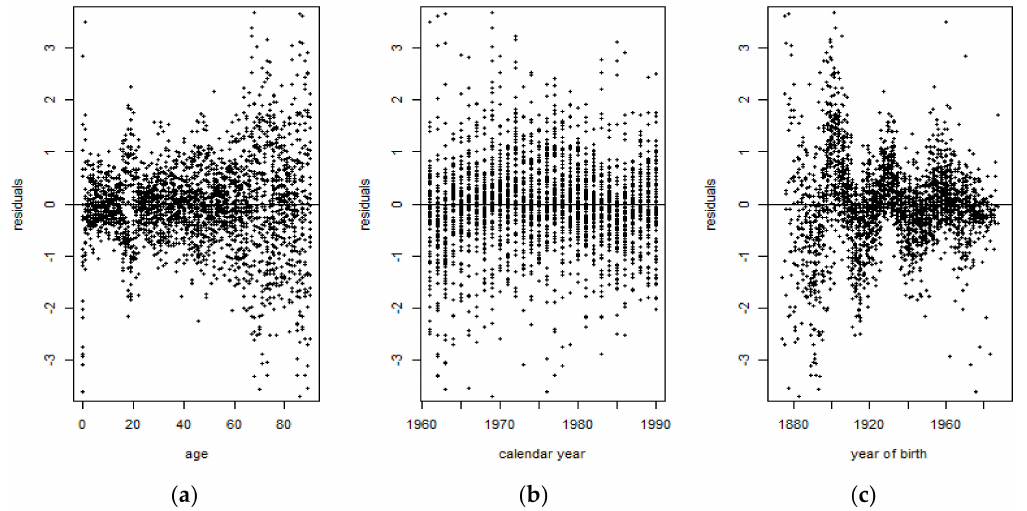
Figure 15. Lee-Carter residuals plotted against ( a ) age, ( b ) calendar year, and ( c ) year of birth for the 1961–1990